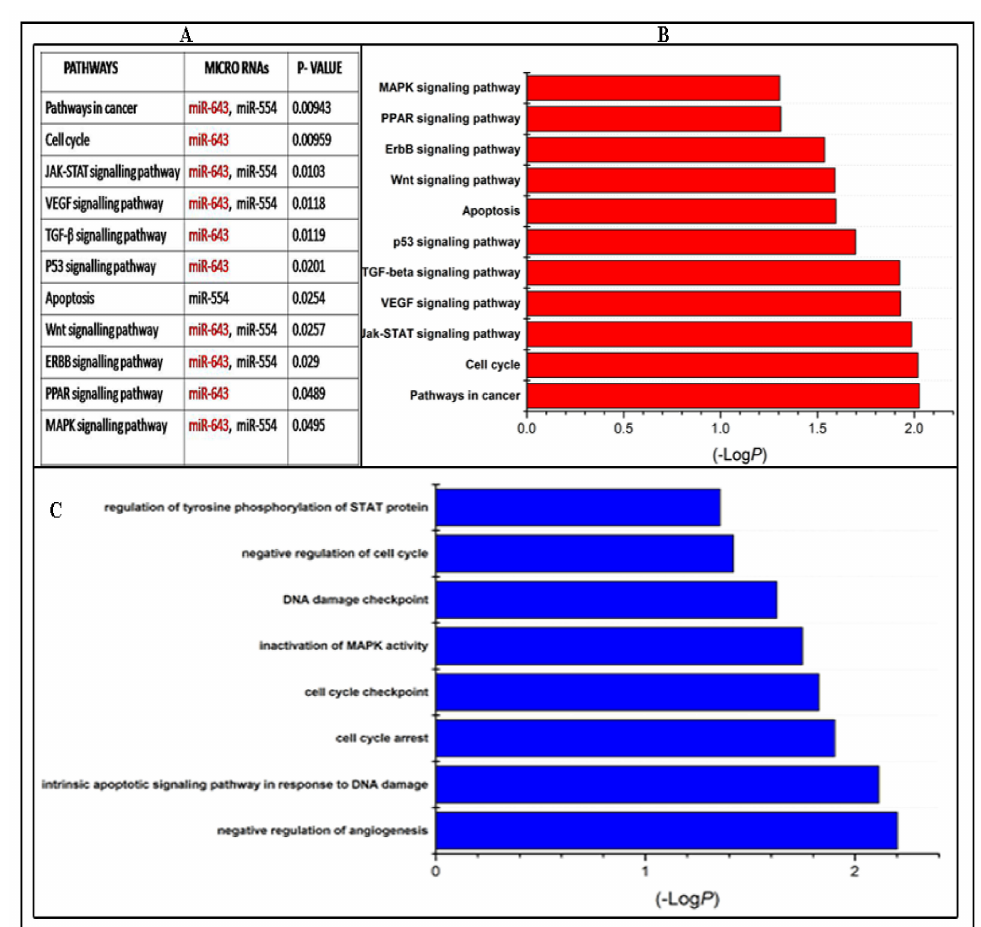
Figure 2. Pathway and GO analysis of candidate miRNAs. Pathway and GO analysis was performed using online web- based tool miRNet. ( A ). Pathways associated with the candidate miRNAs. ( B ). KEGG pathway analysis of candidate miRNA targets. Eleven pathway categories ( p < 0.05) were significantly affected by five candidate miRNAs and five pathway categories were most significantly enriched. The y-axis represents the –log p -value and the x-axis represents different pathways. ( C ). GO analysis of candidate miRNA targets. Eight GO terms ( p < 0.05) were significantly affected by candidate miRNAs and two GO terms were most significantly enriched. The y -axis represents − log p -value and the x-axis represents GO